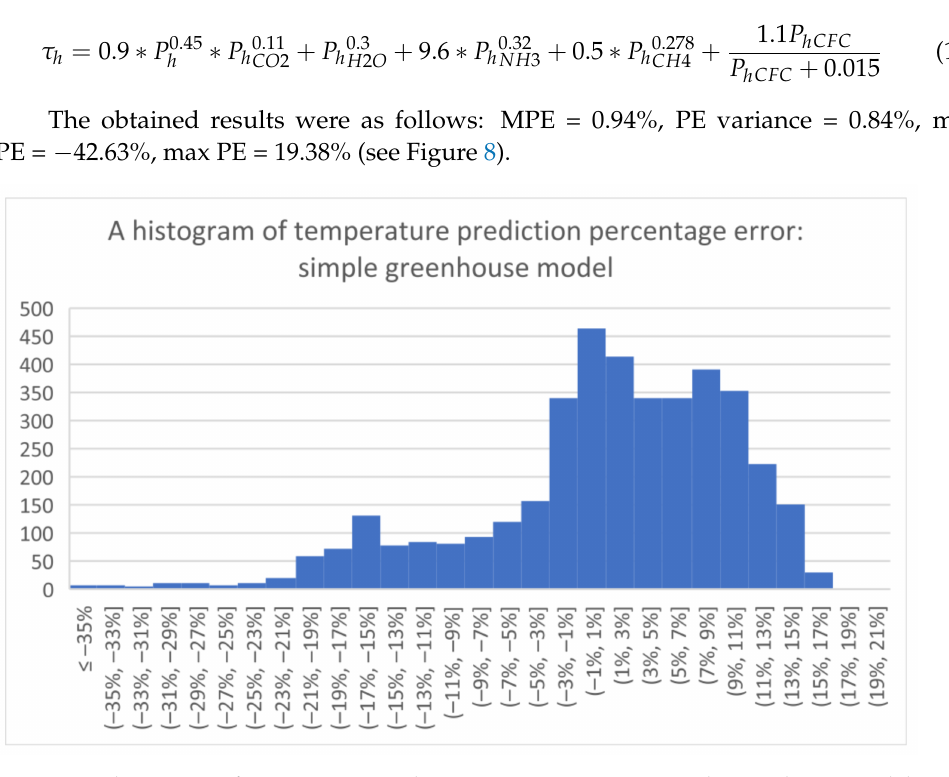
Figure 8. A histogram of temperature prediction percentage error: simple greenhouse